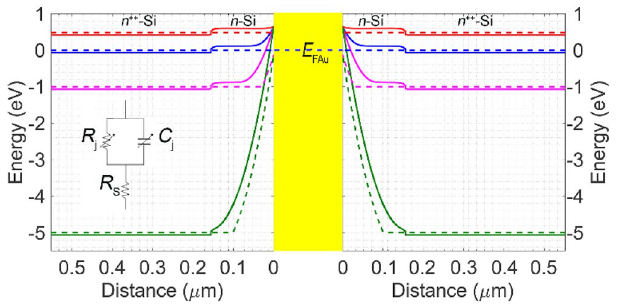
Figure 2. Energy band diagrams of the two adjacent Schottky diodes of Fig. 1c at thermal equilibrium (solid blue), the forward bias of V A = + 0.49 V (solid red), and the reverse biases of V A = − 1 V (magenta) and V A = − 5 V (solid green). The dashed curves represent the corresponding quasi-Fermi levels. The inset shows the equivalent circuit of a Schottky